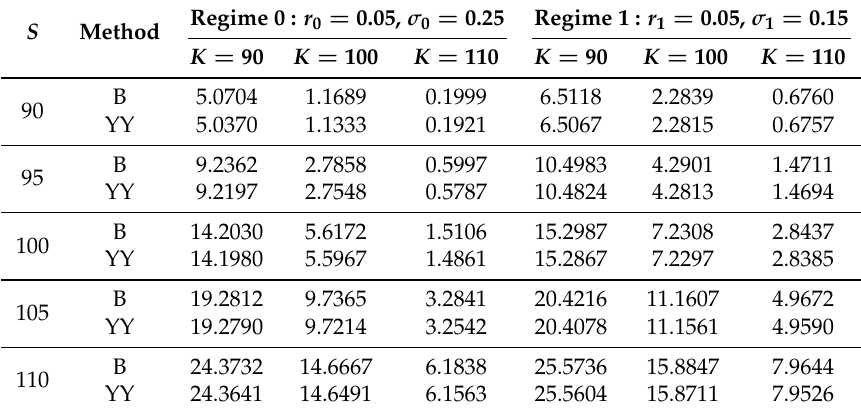
Table 3. American Asian call option prices in a two-regime economy with a 0,1 = a 1,0 = 1